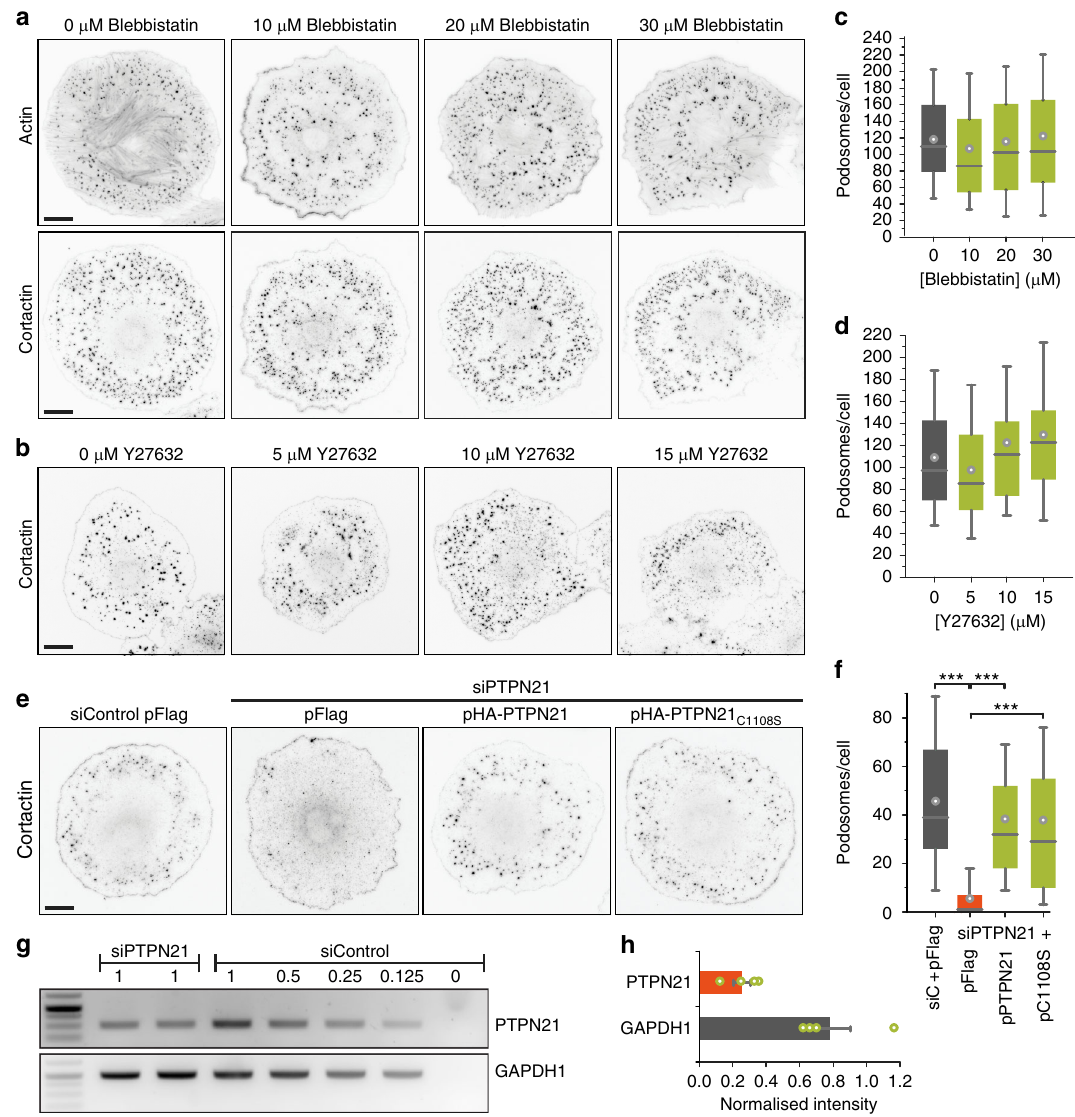
Fig. 3 PTPN21, but not Myosin IIA, is required for podosome formation. a , b A7r5 cells treated with 5 µ M PDBu and different concentrations of Blebbistatin or Y27632 for 1 h before staining for actin and cortactin. Scale bars 20 µ m. e A7r5 cells transfected with siControl and siPTPN21 and either control plasmid (pFlag) or an RNAi-protected construct of wild-type PTPN21 or a catalytically inactive mutant PTPN21C1108S were treated with 5 µ M PDBu for 1 h. Scale bar 20 µ m. c , d , f Quanti fi cation of podosome numbers under different experimental conditions as indicated. n = 90 cells pooled from three independent experiments. Box plots show quartiles with 10/90% whiskers and mean indicated by a circle. Statistical signi fi cance with p < 0.05 is indicated with asterisks, *** represents p < 0.0005 (Mann – Whitney U -test with Bonferroni). Data are provided in Source Data fi le. g , h RT-PCR from random-primed cDNA of A7r5 cells treated with siRNA as indicated. For each experiment, duplicates of siPTPN21 and fi ve different concentrations of cDNA from siControl were analysed. Quanti fi cation of RT-PCR band intensities for siPTPN21 relative to siControl standard curve from four independent experiments is shown as mean ± SEM with overlaid data points. Uncropped gels and data are provided in Source Data fi